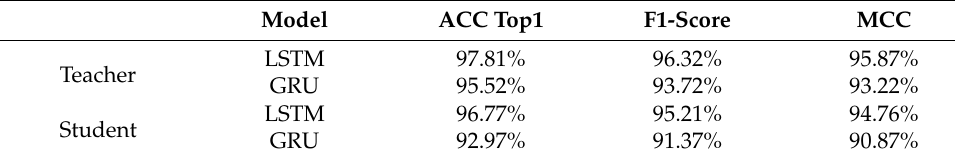
Table 3. CWRU dataset experiment results.